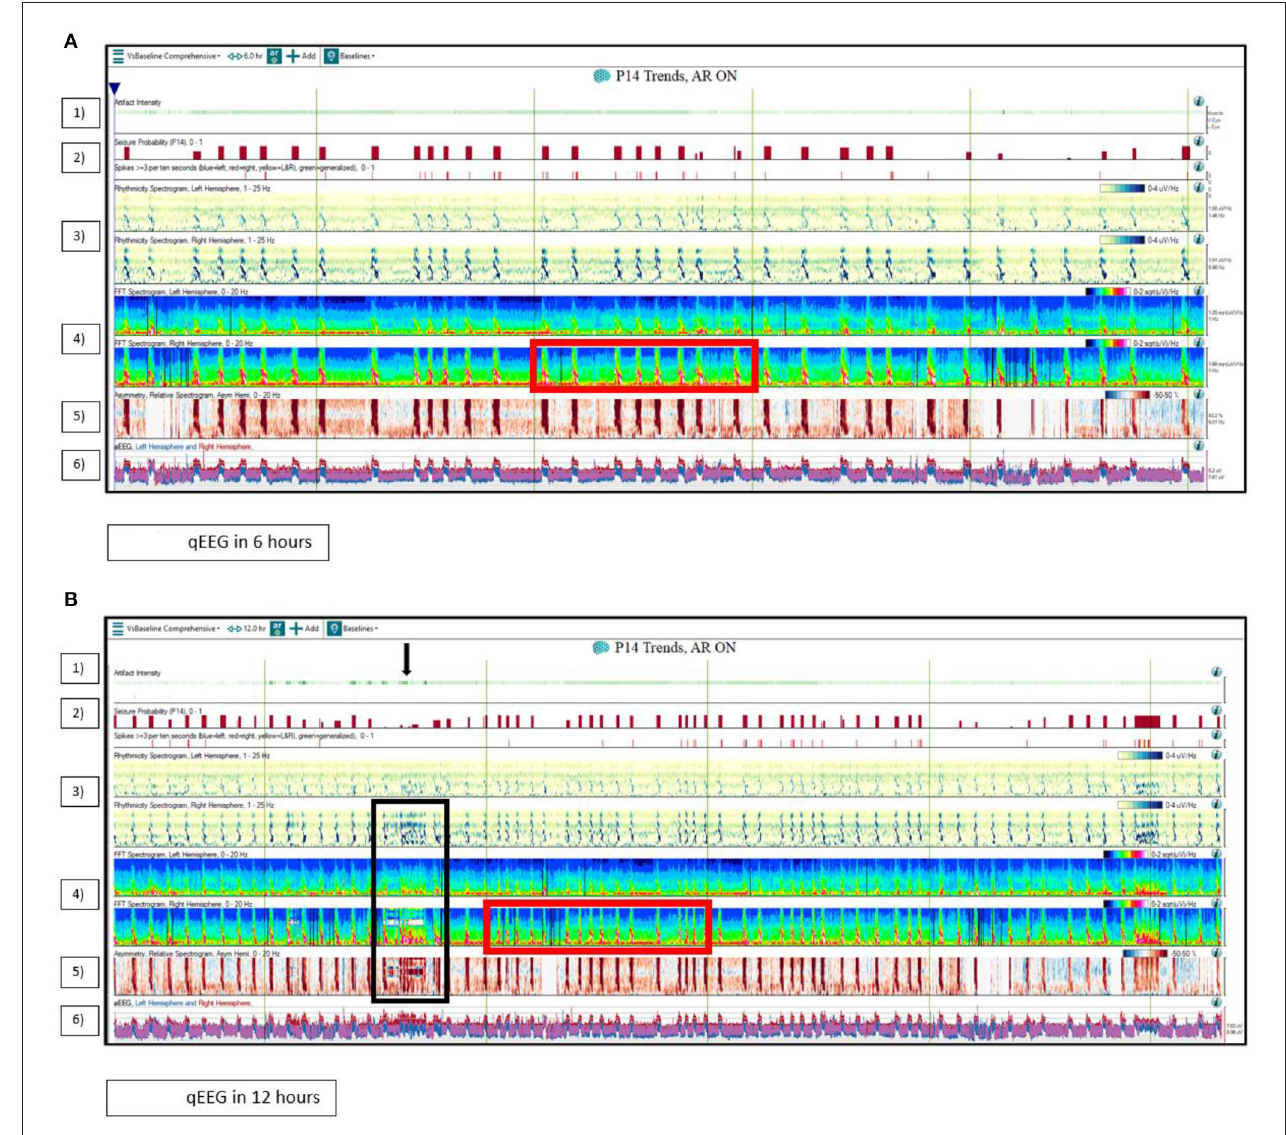
FIGURE 2 | Quantitative EEG (qEEG) use in the ICU. The quantitative EEG (qEEG) in a 71-year-old man with presumed autoimmune/paraneoplastic encephalitis with focal right temporal electro-clinical status epilepticus. (A) displays the qEEG panels in a 6-h window, while (B) displays the qEEG panels in 12h. (1) The artifact intensity panel displays the likelihood that an abrupt change seen on other qEEG trends is likely due to an artifact. Note the abrupt abnormality due to EEG lead disruption in (B) on the right hemisphere rhythmicity spectrogram, the right hemisphere FFT spectrogram, and the relative asymmetry spectrogram that was detected by the artifact intensity panel (Black arrow and black box). (2) The seizure probability (0–1) panel provides a value between 0 and 1 to indicate the seizure probability as estimated by the software. (3) The left and right rhythmicity spectrogram panel displays the power characteristics for each frequency band (1–4, 4–9, 9–16, and 16–25Hz) as a function of time. Note the increased power peaks over the right rhythmicity spectrogram panel. (4) The left and right FFT (fast Fourier transform) spectrogram panel displays the color-coded power of different EEG frequency bands as a function of time. Note the distinct “flame” appearing peaks in the right FFT spectrogram panel indicating discrete right temporal seizures (Red box). (5) The relative asymmetry spectrogram panel (left in blue and right in red) displays power differences between homologous electrodes at discrete frequencies and illustrates power asymmetry across the two hemispheres. Note the several peaks in red. (6) The left (in blue) and right (in red) hemisphere amplitude EEG (aEEG) panel displays amplitude characteristics of the EEG as a function of time. Note the higher amplitudes over the right hemisphere.